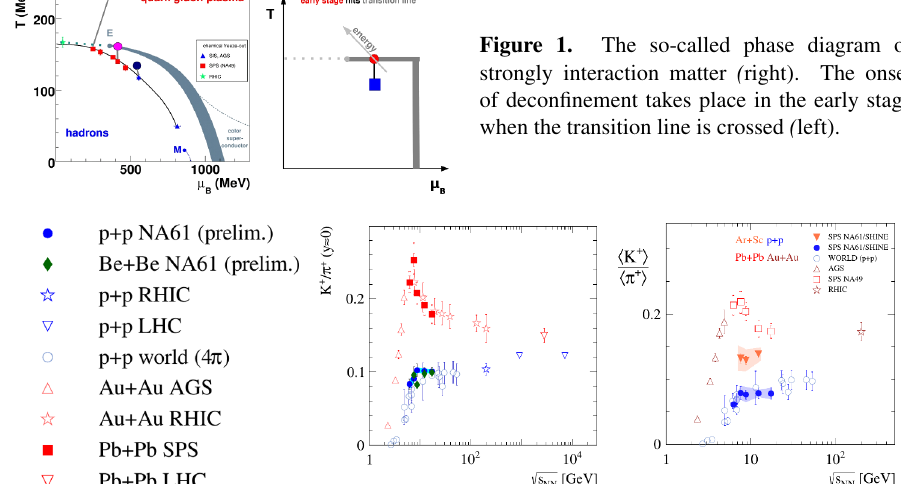
Figure 2. Particle ratios for K + / π + ( left) and (cid:104) K + (cid:105) / (cid:104) π + (cid:105) ( right). The horn structure is clearly visible for Pb + Pb collisions, while for p + p a step is observed. However, while Be + Be is close to p + p, Ar + Sc (cid:104) K + (cid:105) / (cid:104) π + (cid:105) is in between p + p / Be + Be and Pb + Pb.